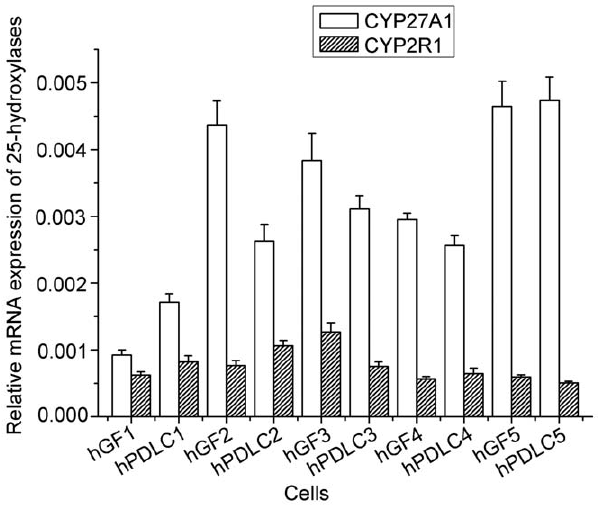
Figure 1. Expression of CYP27A1 and CYP2R1 mRNA in hGF and hPDLC. Expression of CYP27B1 mRNA was detected by real-time PCR in hGF and hPDLC from all five donors (donors are numbered 1–5). The expression levels of CYP27A1 and CYP2R1 mRNA were not significantly different in the two kinds of cells. The data are presented as the mean 6